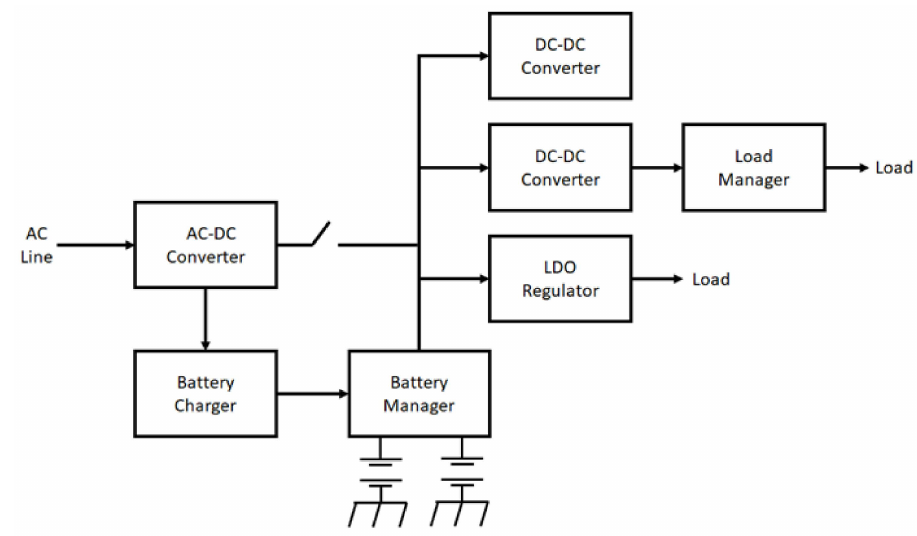
Figure 1. Block diagram of a generic power management system [1].